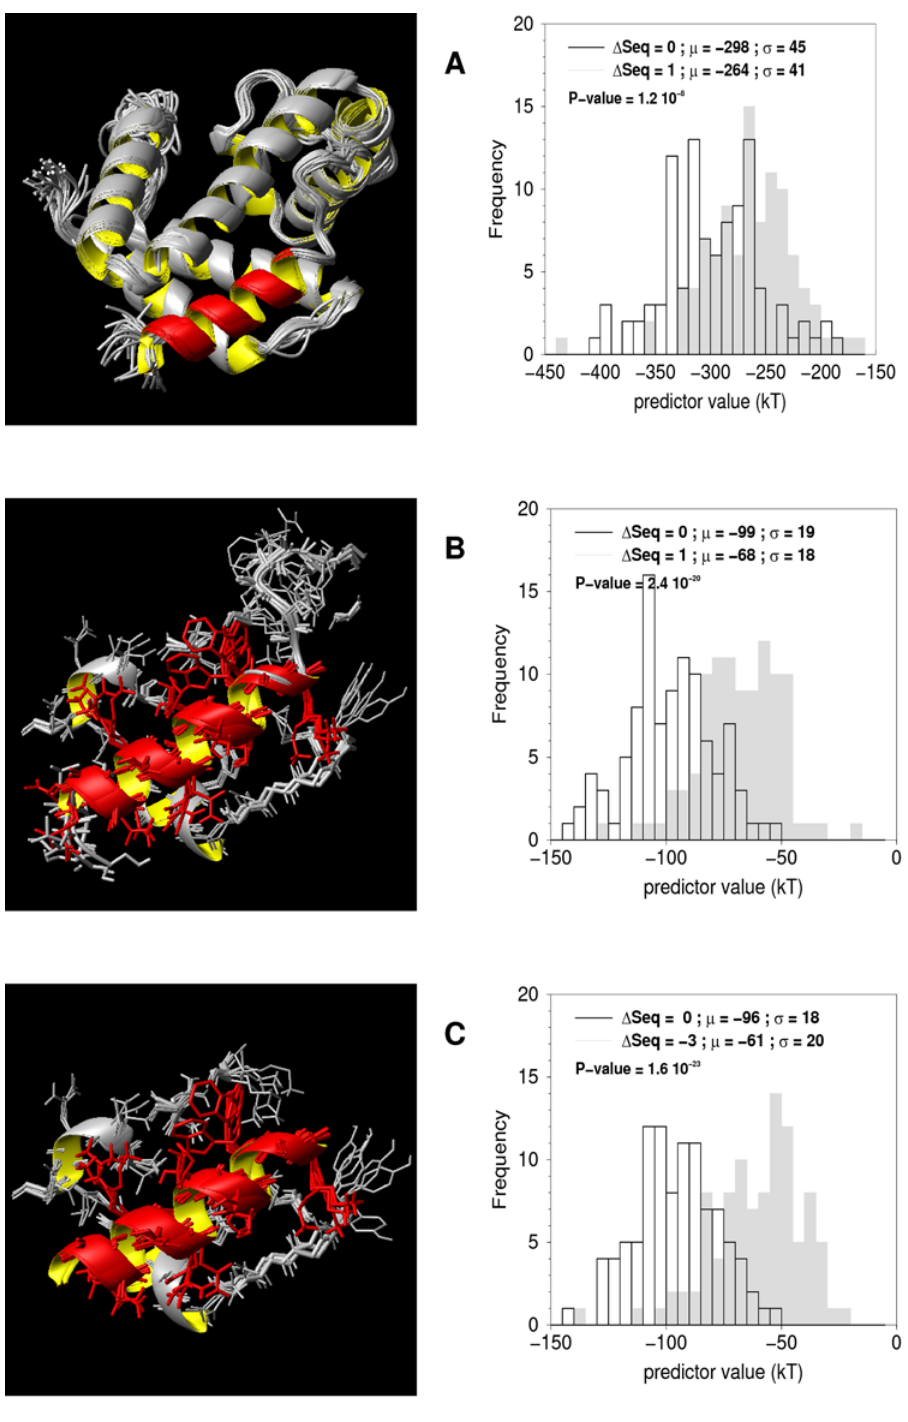
Figure 7. ANOLEA-based predictors’ values distribution for the three different residues selections. A hundred models of 1flp helix1 test case are superimposed. Only parts of the protein involved in each selection are represented and the corresponding predictor values distribution are shown. The SSE in the ROI is represented in red. A, Predictor ANOLEA/All. B, Predictor ANOLEA/ROI Local. C, Predictor ANOLEA/SSE Local. The black and gray colored histograms represent the predictors values distributions for the lowest predictor scores (structural alignment, :seq=0) and for the second lowest one, respectively. The bin width is set equal to the quarter of the variance (10 for A, 5 for B and C). doi:10.1371/journal.pone.0002645.g007 when sequence identity is low. Although energy-based methods evaluate a single alignment when using a sensitive and accurate scoring function. The reliability of the prediction is greatly are widely used to tackle this problem, they are currently limited by their accuracy. This study shows that a small number of high- enhanced by considering only the SSE to optimize and its quality, all atom, and minimized models are sufficient to reliably interaction with residues of adjacent SSEs only, neglecting the